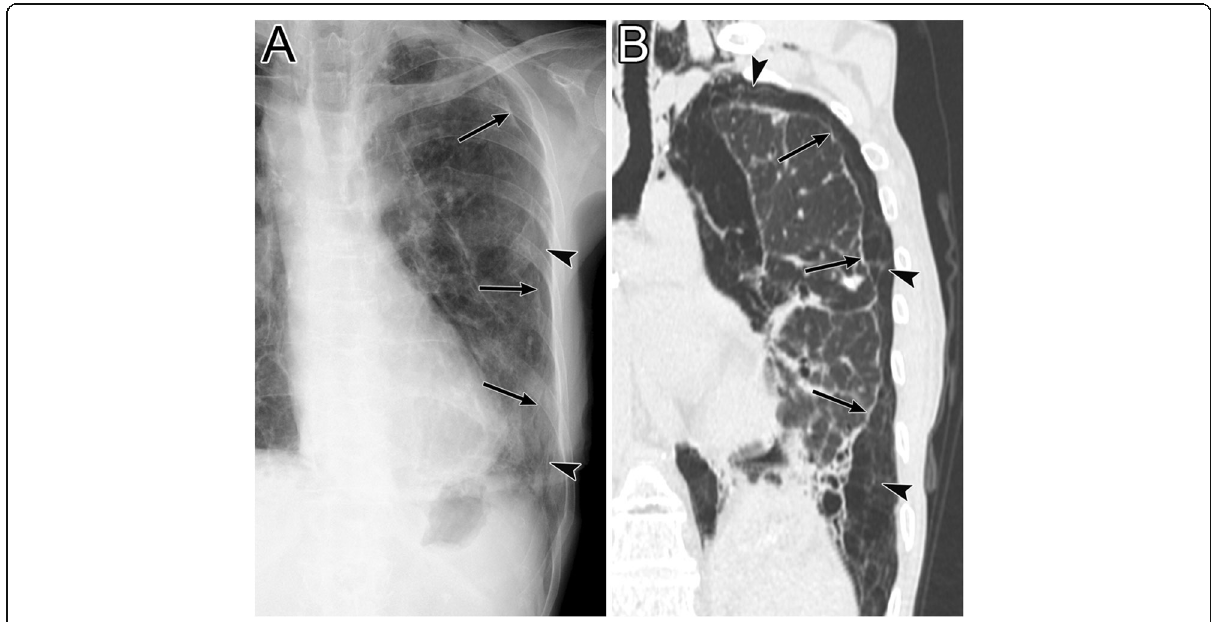
Fig. 11 Air collection in the intrathoracic extrapleural space of a 64-year-old woman. She has Sjögren ’ s syndrome and interstitial pneumonia. a A supine radiograph shows a linear opacity (black arrows) in the left peripheral lung field that resembles pneumothorax. Fascial webs (black arrowheads) are visible outside of the linear opacity; this finding proves that air does not exist in the pleural cavity but collects in the intrathoracic extrapleural space. The linear opacity is composed of both the visceral and parietal pleura. Pneumomediastinum and subcutaneous emphysema are also visible. b A coronal CT image clearly depicts fascial webs (black arrowheads) in the intrathoracic extrapleural space. The mixture of the visceral and parietal pleura (black arrows) is slightly wavier than the typical visceral line in